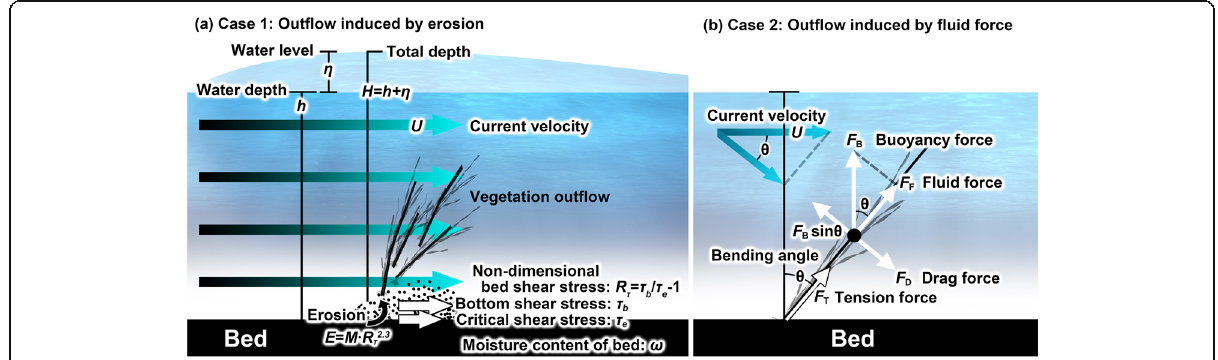
Fig. 2 Conceptual diagrams of the two processes responsible for the vegetation outflow induced by the high-speed current. a Erosion (case 1) evaluated by the nondimensional bed shear stress and the sediment flux from the bed to the lake water. b Fluid force (case 2) represented by the resultant of the buoyancy and drag forces. The variables depicted in the diagram are explained further in the text